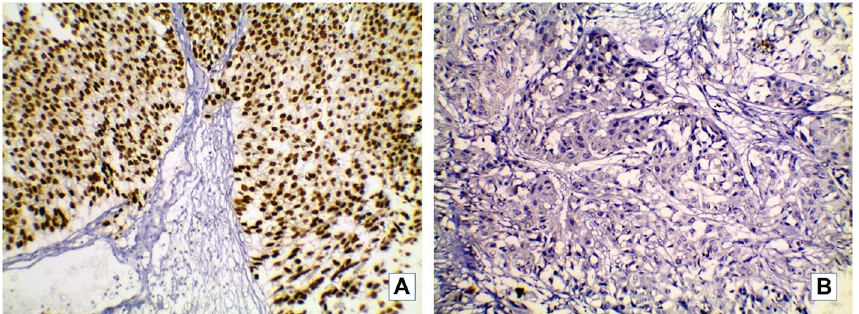
Fig. 1 Representative image of GATA3 immunostain in studied MIBC cases. A : A case of urothelial carcinoma showing positive nuclear GATA3 (